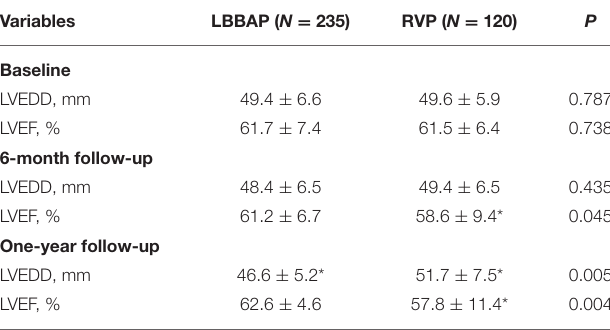
TABLE 2 | Pacing characteristics during the procedure and follow-up. TABLE 3 | Echocardiographic measures at baseline and during follow-up.